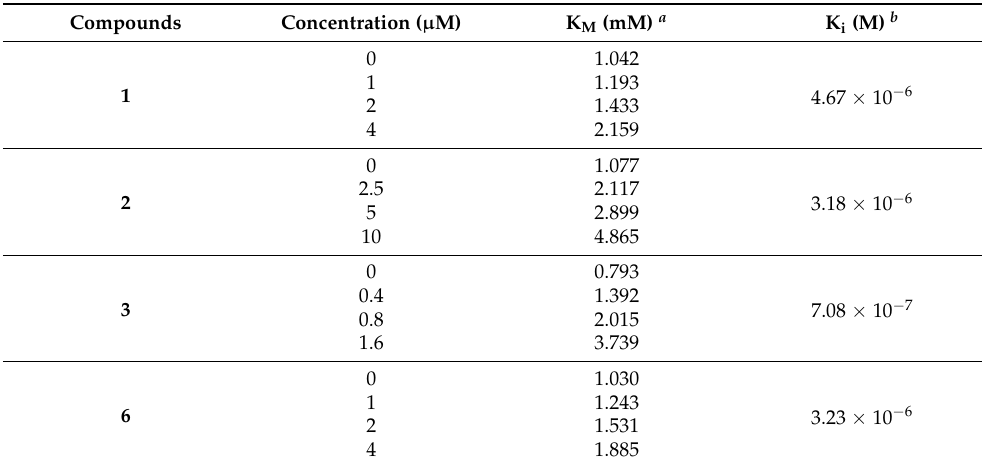
Table 3. Michaelis–Menten constants (K M ) and inhibition constants (K i ) for mushroom tyrosinase inhibition by analogs 1 , 2 , 3 , and 6 .